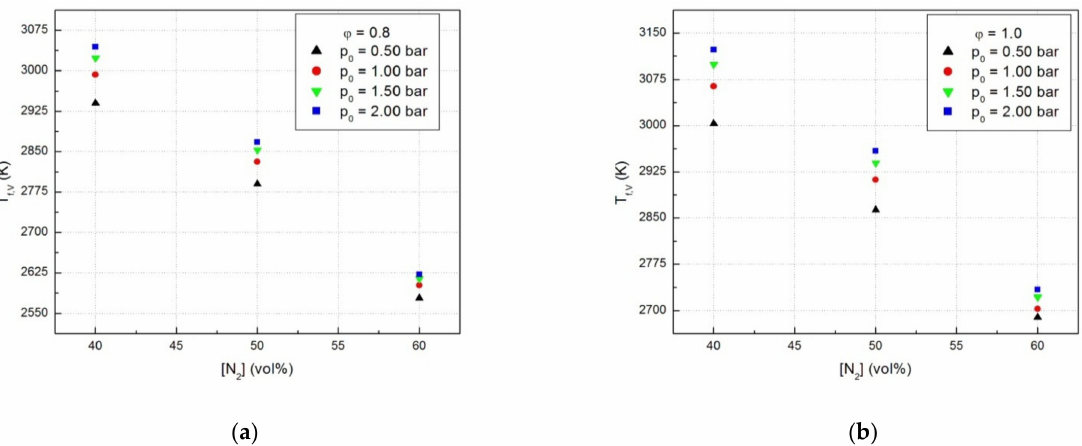
Figure 7. Adiabatic flames temperatures of CH 4 -N 2 O mixtures in the presence of N 2 : ( a ) for equivalence ratio φ = 0.8 and ( b ) for equivalence ratio φ =